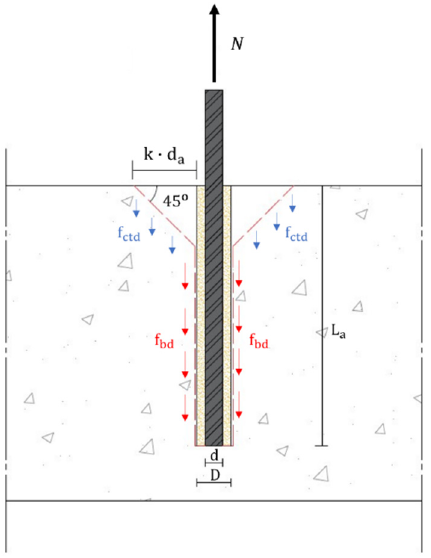
Table 12. Steel reinforcing bars for I1 intervention ( 𝜁 (cid:3006) ≥ 0.60).